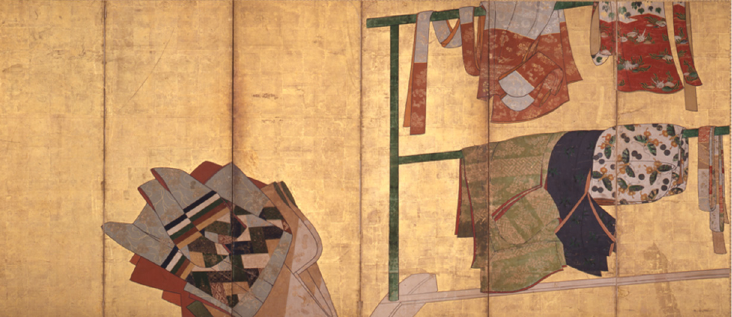
Figure 1. Author unknown, Whose Sleeves? (Tagasode Screen) , six-fold screen, color on paper, 149.5 × 348.2 cm, 17~18c, Mitsui Memorial Museum, Tokyo, Japan. 149.5 × 348.2 cm, 17~18c, Mitsui Memorial Museum, Tokyo,